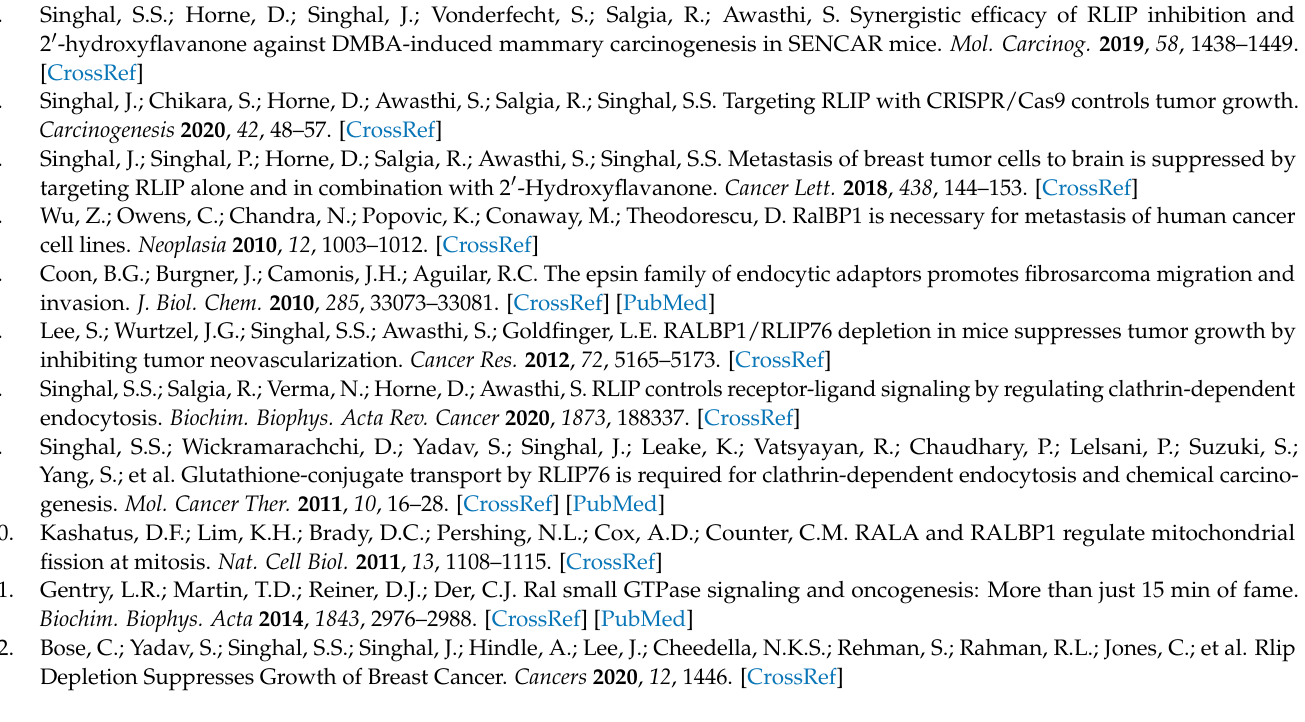
Figure S3: Vehicle effects on mRNA expression in MCF7 cells. Figure S4: Impact of Rlip-LNA on reporter transfection efficiency. Figure S5: Luciferase reporter expression patterns are not driven by cytotoxicity. Figure S6: Densitometric quantitation of Rlip overexpression by the Rlip-pcDNA3.1 expression plasmid in H358